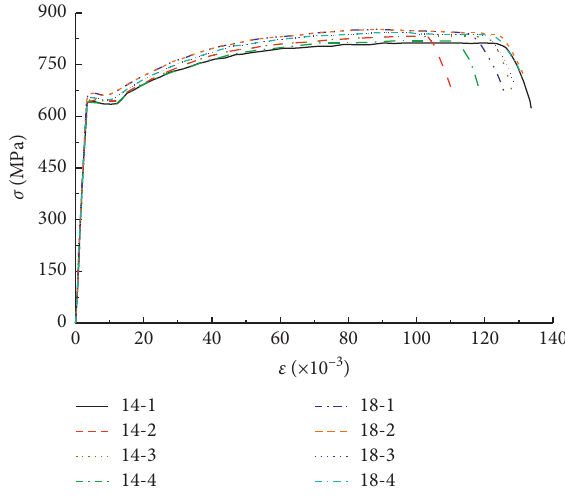
Figure 3: Stress-strain curves of 600MPa steel